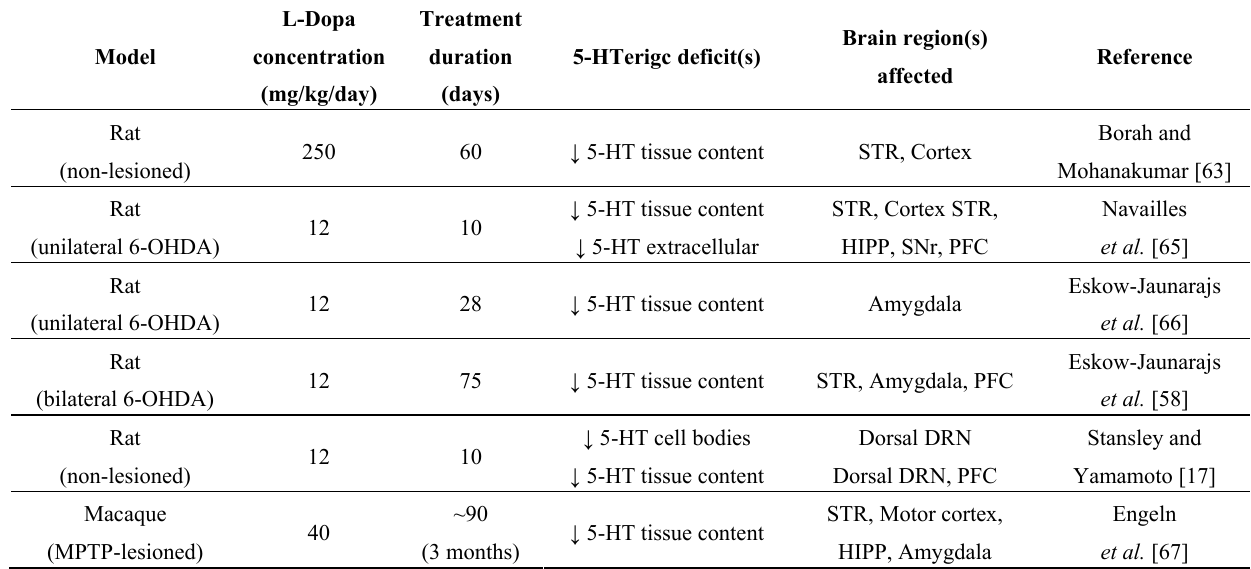
Table 1. A selection of studies highlighting the 5-HT deficits caused by chronic L